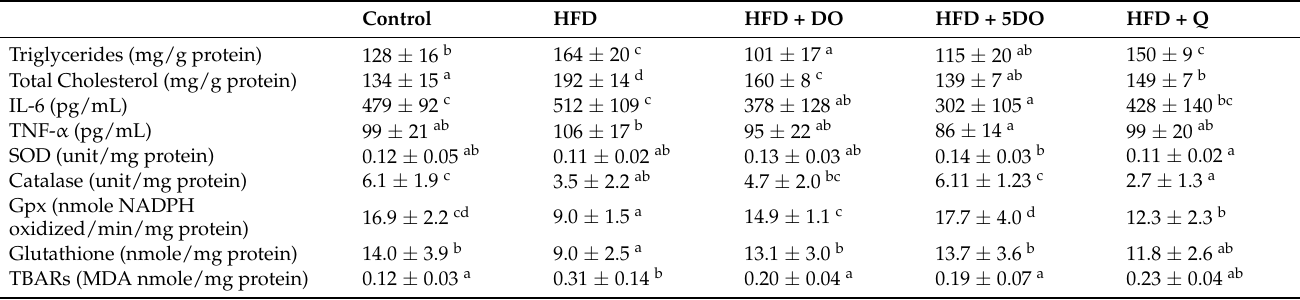
Table 4. Effects of dried onion powder and quercetin on lipid profile and the levels of pro- inflammatory cytokine and anti-oxidative parameters in liver in Sprague Dawley rats exposed to HFD 1